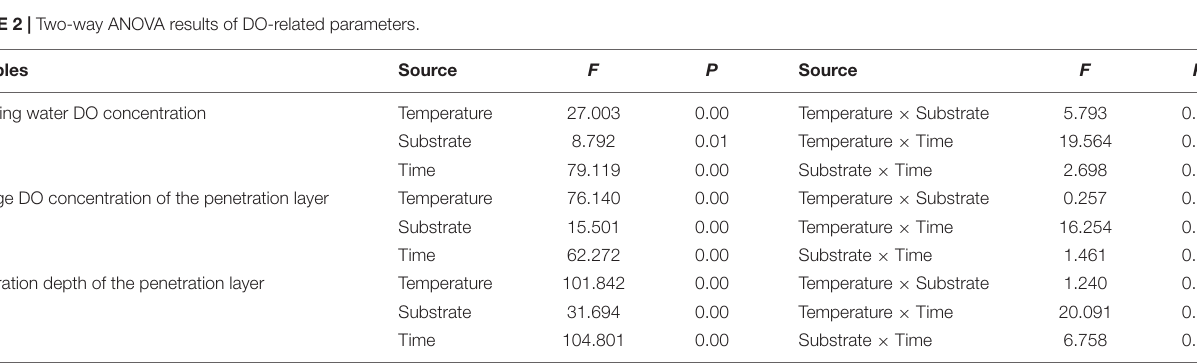
TABLE 2 | Two-way ANOVA results of DO-related